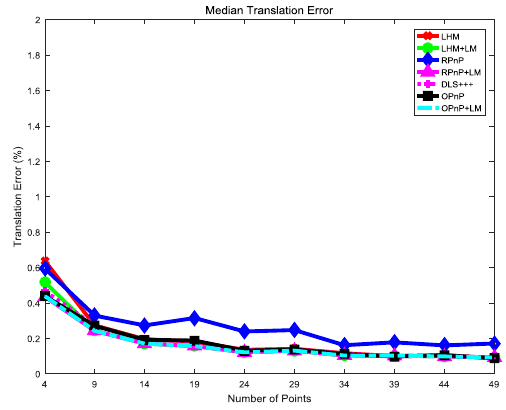
Figure 4. Median translation error w.r.t. varying number of